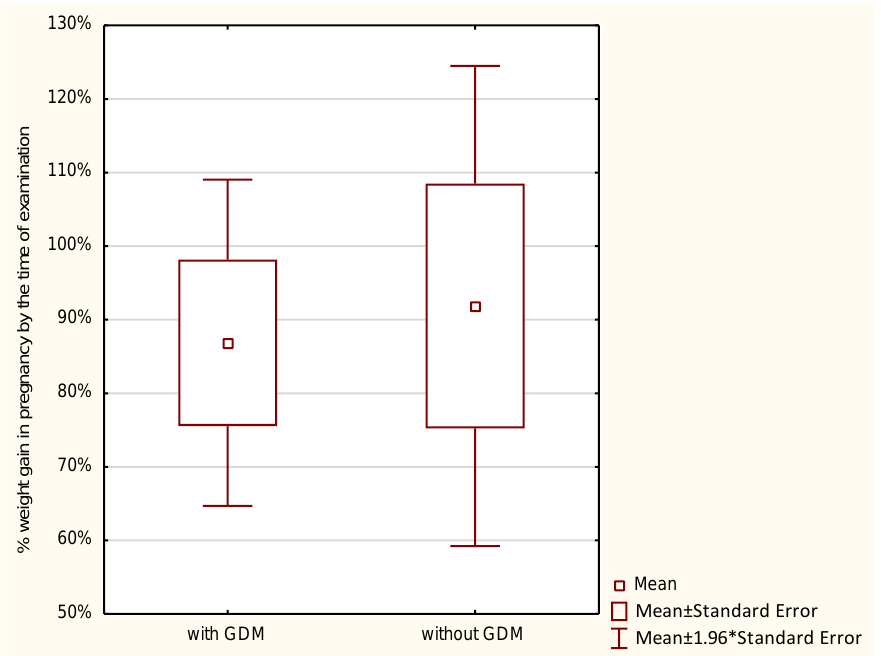
Figure 2. The percentage of GWG by the time of examination performed in pregnancy in relation to GDM.